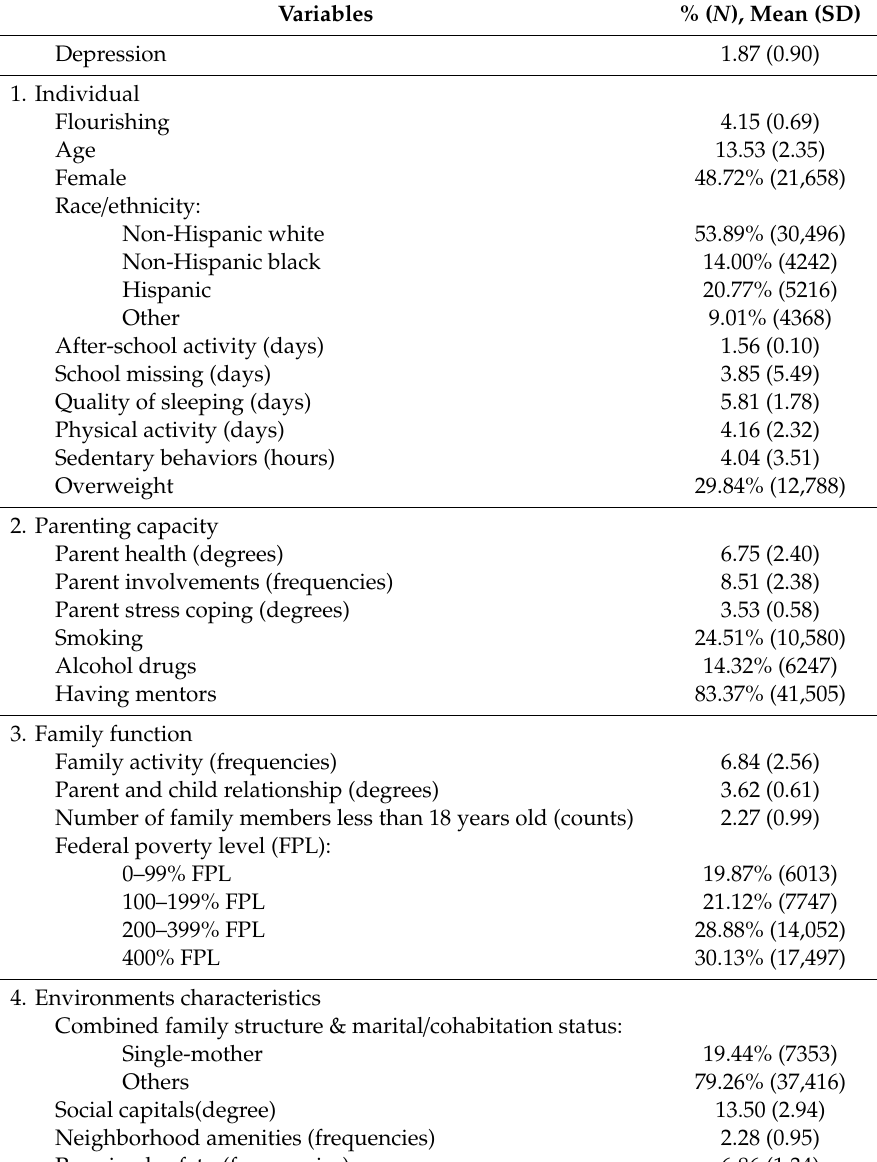
Table 1. Descriptive statistics of the study